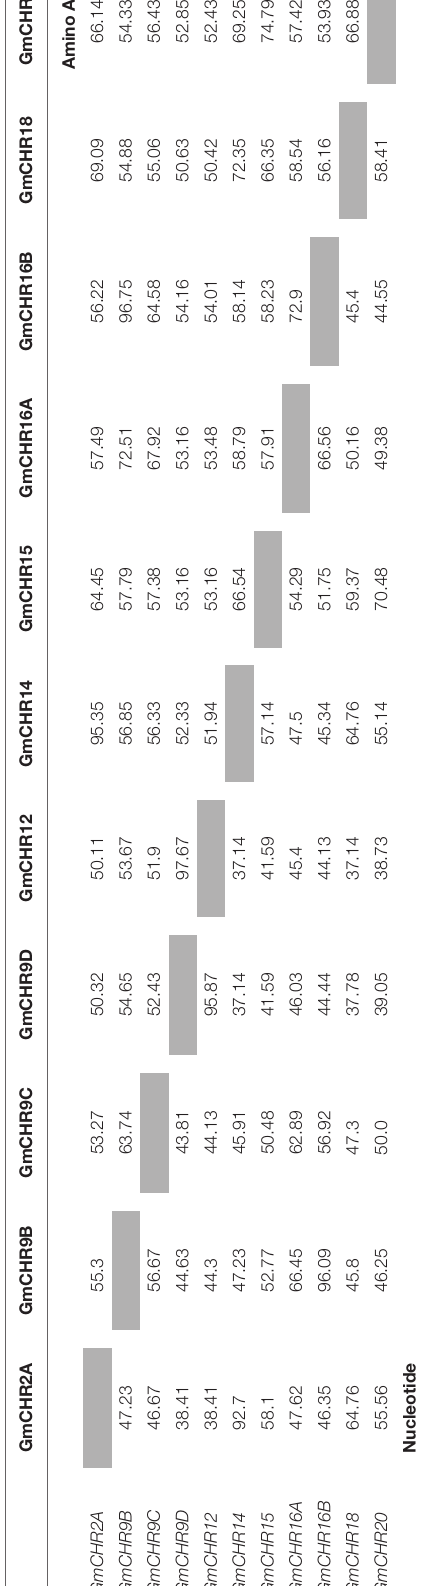
GmCHR14 and GmCHR18 transcripts were significantly higher at 12, 24, 48, and 72 h post AgNO 3 treatment compared to the control samples whereas increased accumulation of GmCHR20 was only observed at 6 and 72 h in AgNO3-treated hypocotyls compared to the controls ( Figure 5C